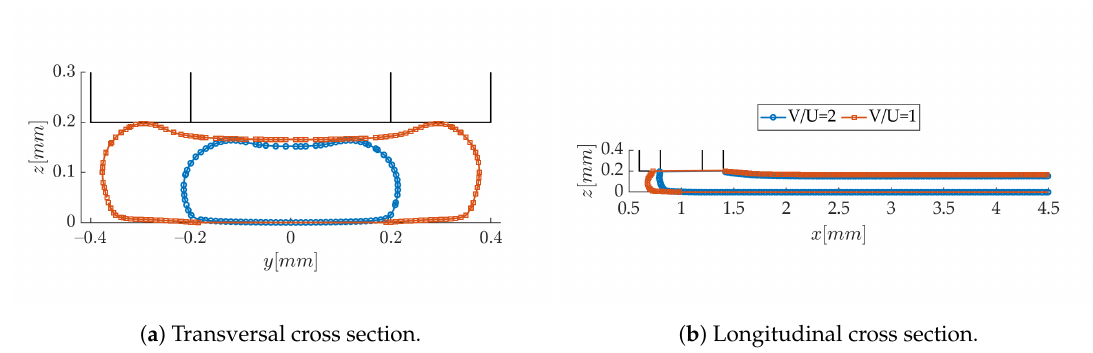
Figure 14. Effect of the velocity ratio on the strand shape at h / d = 0.5.